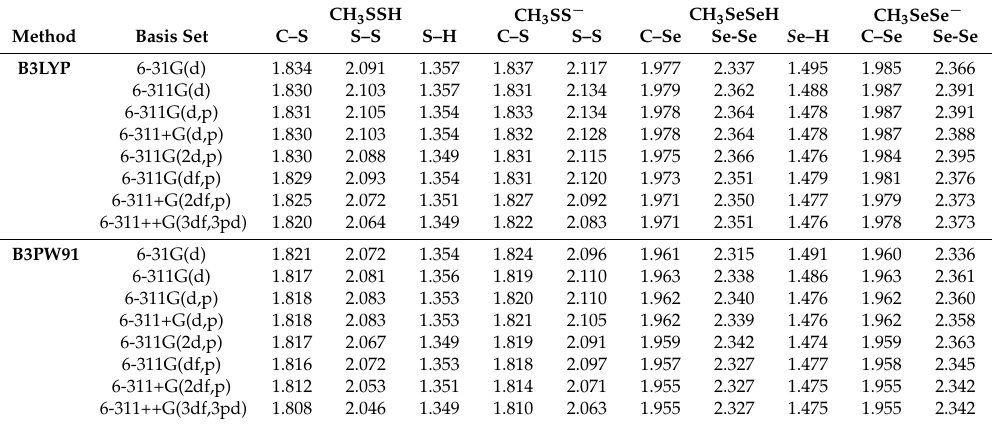
Table 1. Selected optimized bond lengths (in ångstroms; Å) for CH 3 XXH and CH 3 XX − (X = S, Se). CH 3 SSH